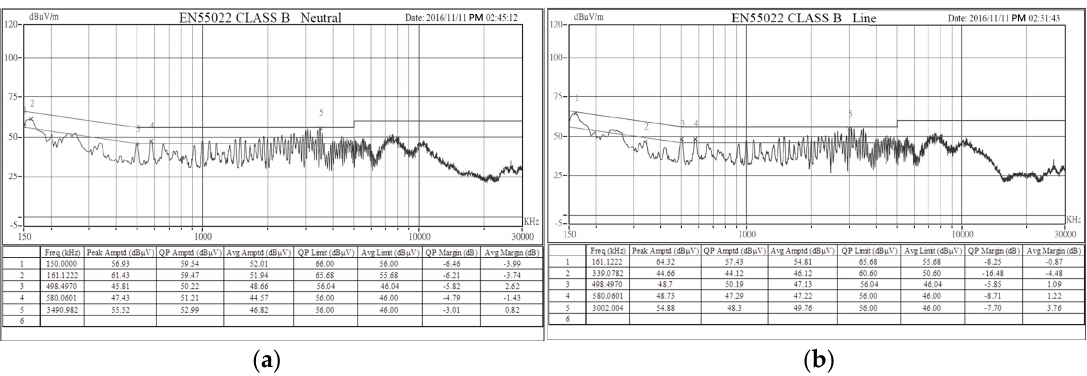
Figure 22. Conducted EMI measurements in the X -capacitor of 0.22 μ F (fixed frequency): ( a ) neutral; ( b ) line.